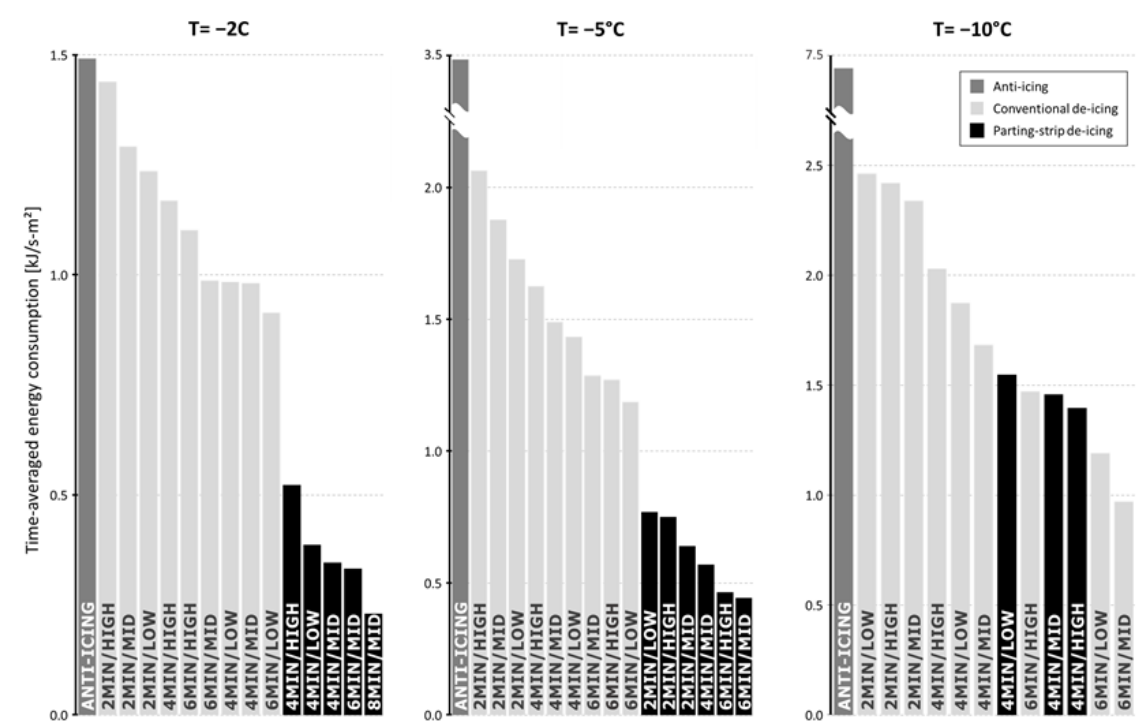
Figure 16. Overview of the time-averaged total energy consumption for all IPS runs.